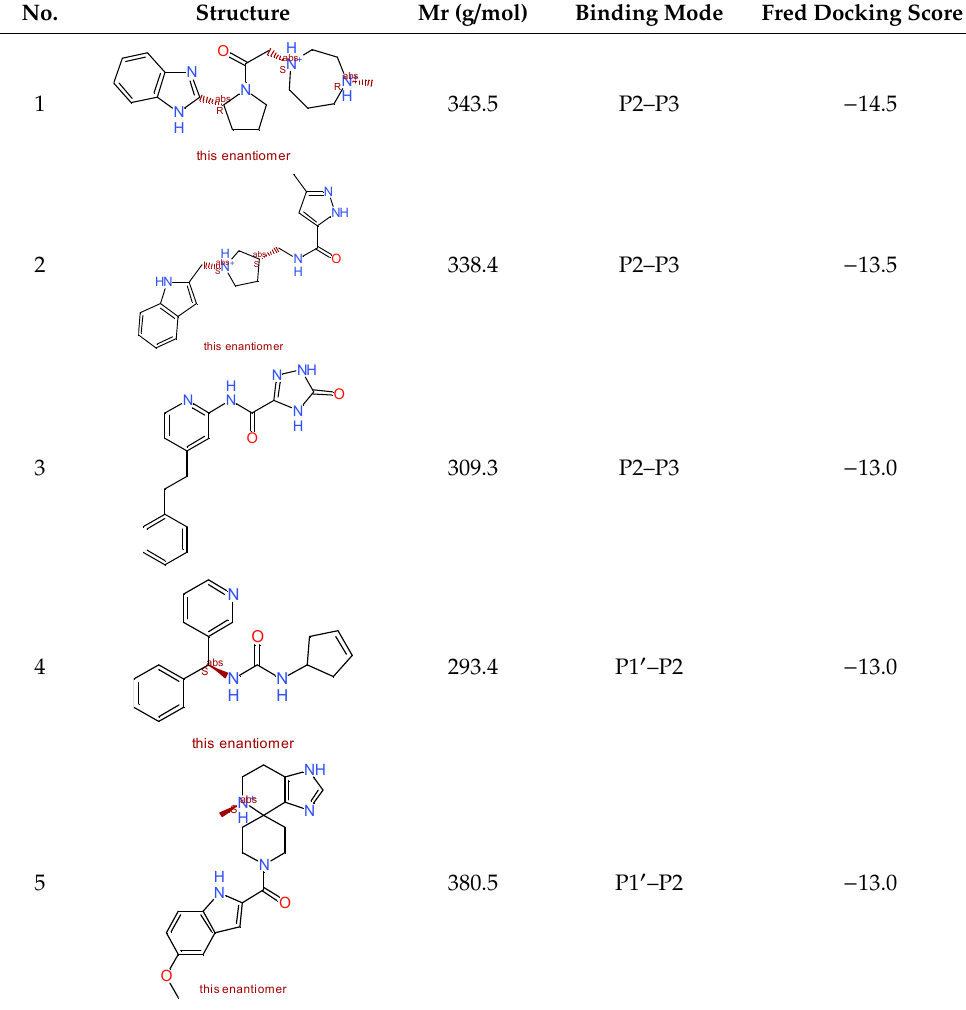
Table 1. Identified top-scoring compounds in the ensemble docking VS on the SARS-CoV-2 main protease (for the complete list see Table S5 in the Supporting Information).